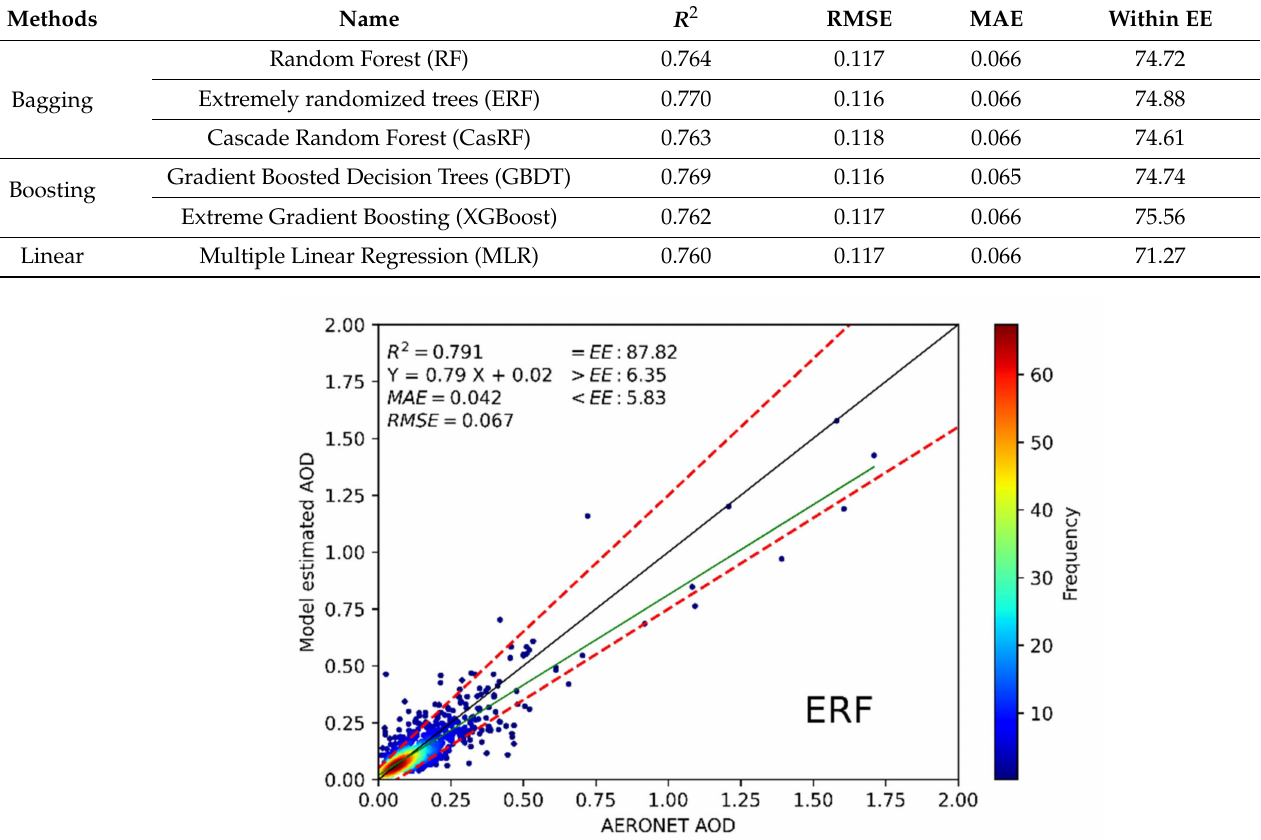
Figure 3. Density scatterplots of the estimated results for the different machine learning models (N = 1133). Color scale indicates the density of observation. The red dashed line and the black and green solid lines represent the MODIS expected error, the 1:1 line and the linear regression line,